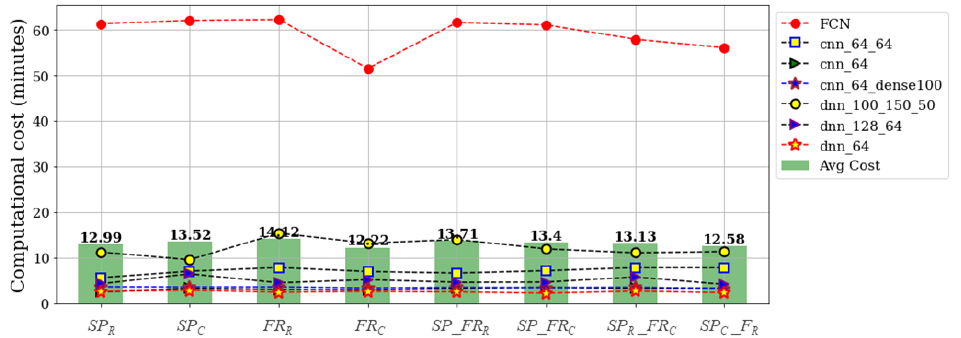
Figure 11. Computational cost assessment of the DL models on the different input/source data channels. The green bars (Avg cost) are the mean value of the computational costs of the DL models per input/source data